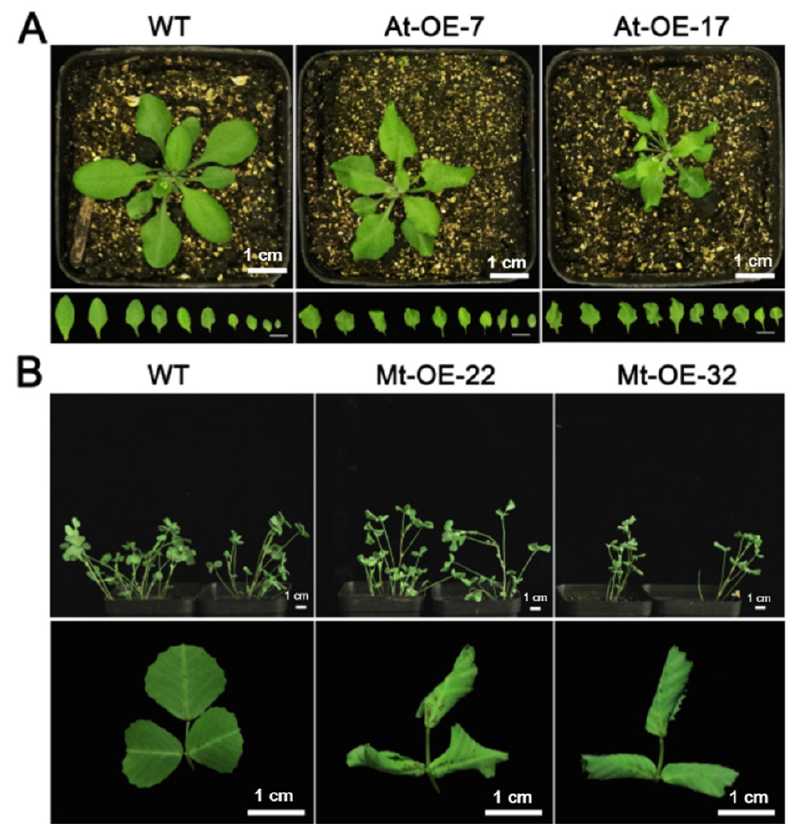
Figure 2. Phenotypes of leaf curl after overexpressing Mtr-miR319a : phenotypes in the leaves of A. thaliana ( A ) and M. truncatula ( B ) of the WT and Mtr-miR319a -overexpressing plants. Mature WT A. thaliana plants and Mtr-miR319a- overexpressing plants of At-OE-7 and At-OE-17, as well as mature WT M. truncatula plants and Mtr-miR319a- overexpressing plants of Mt-OE-22 and Mt-OE-32 are shown. Bar = 1 cm.